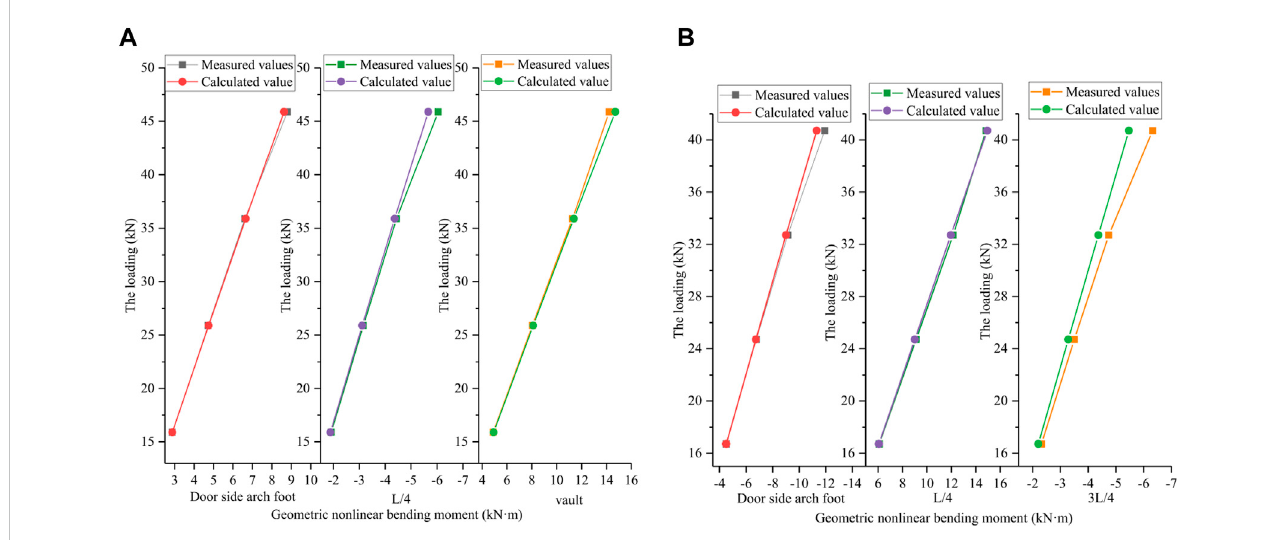
FIGURE 14 Comparison of geometric non-linear bending moment values between the “ arch mode ” and “ rod mode ” : (A) A-1 arch; (B) A-2